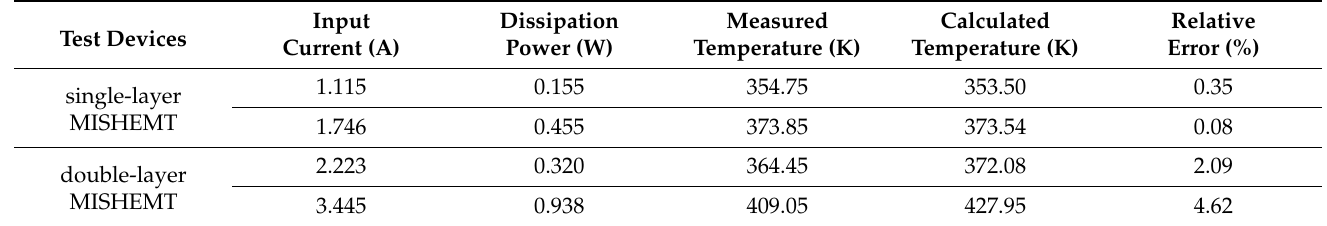
Figure 7. Temperature distribution of devices under different I ds : ( a ) single−layer MISHEMT under I ds = 1.115 A, ( b ) single−layer MISHEMT under I ds = 1.746 A, ( c ) double−layer MISHEMT under I ds = 2.223 A, ( d ) double−layer MISHEMT under I ds = 3.445 A. (The steady−state surface temperatures of MISHEMTs are detected by the high−speed dynamic infrared thermal imager (TM−HST)). Table 2. Comparisons: measured result and calculated result of surface